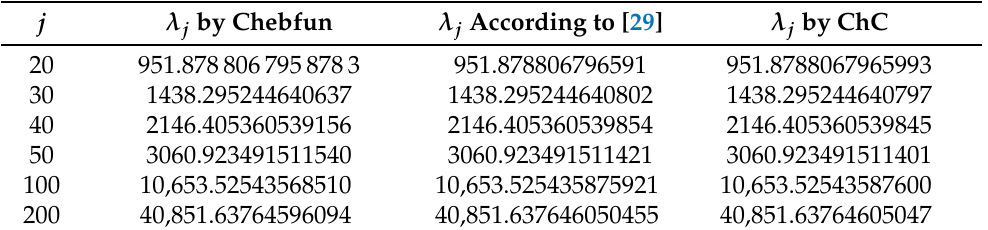
Table 1. High index eigenvalues of Schrödinger eigenproblem equipped with Coffey-Evans poten- tial (3) computed by three different